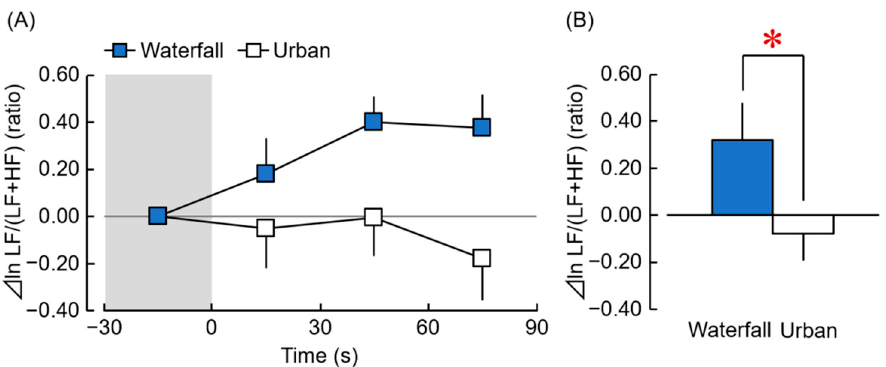
Figure 4. Changes in the ratio of ln LF/(LF+HF) of HRV exposure to the waterfall vs. urban images.